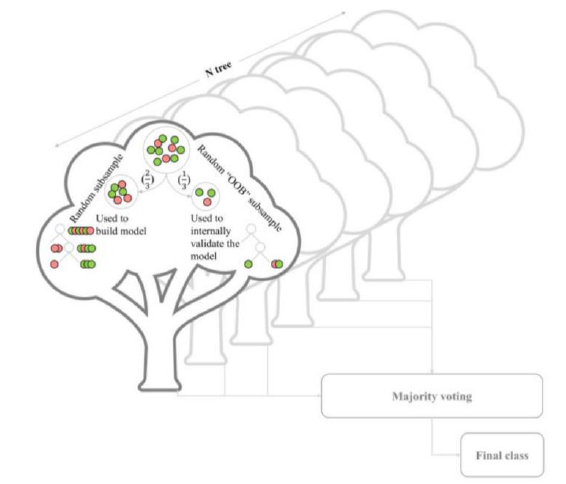
Figure 3. Random Forest algorithm (Sheykhmousa et al.